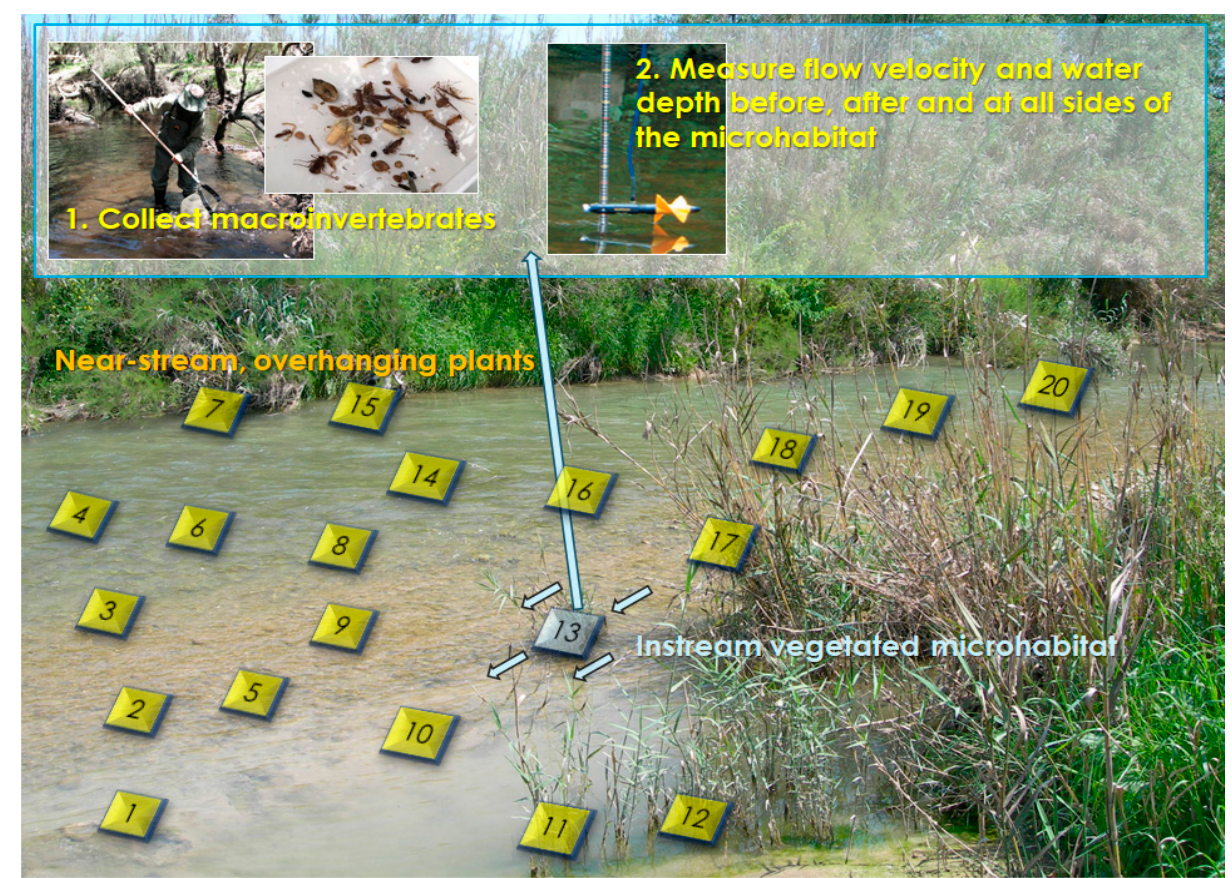
Figure 2. Sampling methodology: a total of 124 microhabitats in the Oinoi Stream and the upper Great Rafina River (Lykorema Stream), Attica, Greece, were sampled for macroinvertebrates, with simultaneous measurements of flow velocity and water depth, before, after, and on each side of each microhabitat.